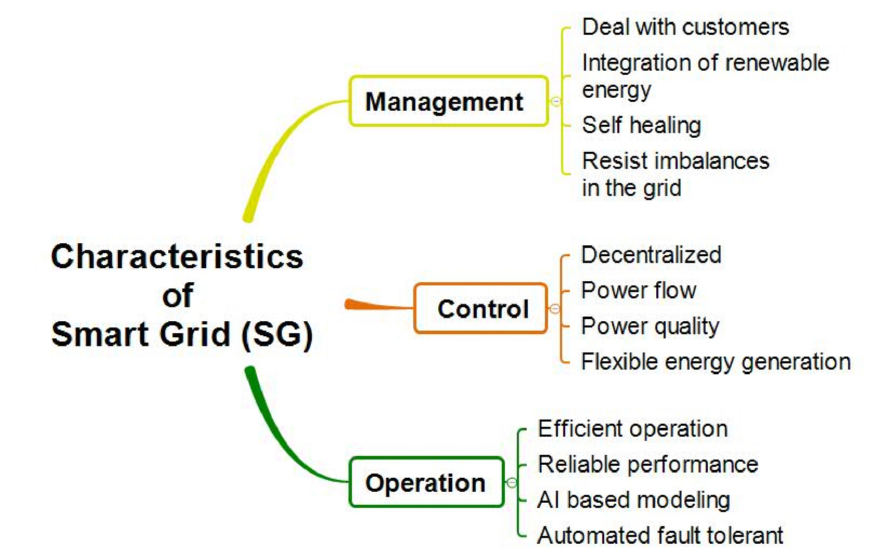
Figure 2. Characteristics of smart